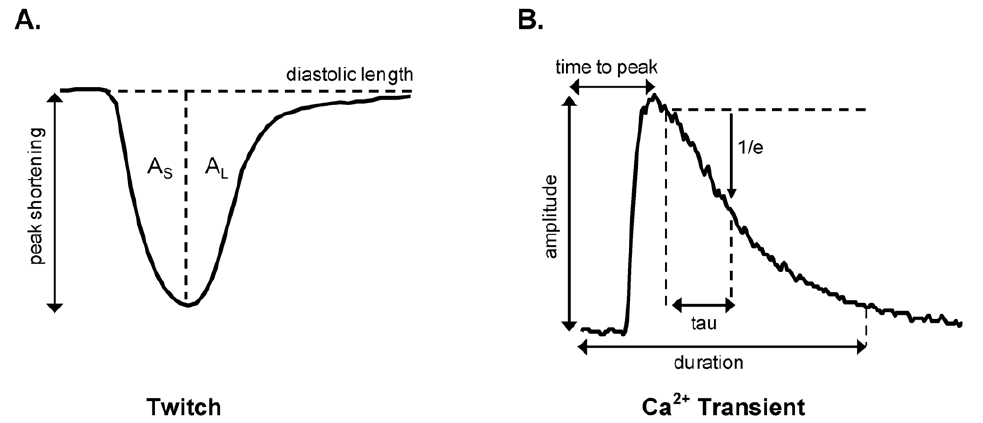
Figure 1. Cardiomyocyte excitation-contraction coupling analysis. A. Parameters used to describe the myocyte twitch cycle were peak shortening (PS, m m), peak shortening normalized to diastolic cell length (%PS), area of the shortening phase (A S , m m*ms), area of the lengthening phase (A L , m m*ms) and area of the total twitch cycle (A T =A S + A L , m m*ms). Area values were determined between baseline and cell length and were normalized to peak shortening amplitude (A S /PS, A L /PS, A T /PS; m m*ms/ m m) in order to compare the relative periods of the shortening and relaxation periods in different myocytes. B. Parameters used to describe the Ca 2 + transient were amplitude (nM), time to peak (ms), time constant of decay (Tau, ms) fit from 10% below transient peak, and duration (to 90% Ca 2 + transient decay, ms). Transient timing parameters (time to peak and duration) were referenced to time of stimulus delivery.